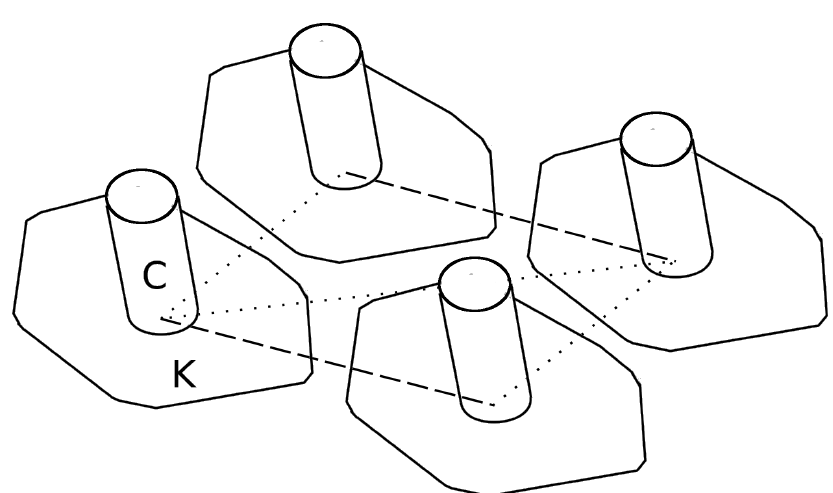
Figure 2. Schematic diagram to demonstrate the location within kinetid basins, from the top-down view of the P. caudatum pellicle. C: Cilium; K: Kinetid; dashed line: Kinetodesmal fibrils; dotted line: infraciliature.